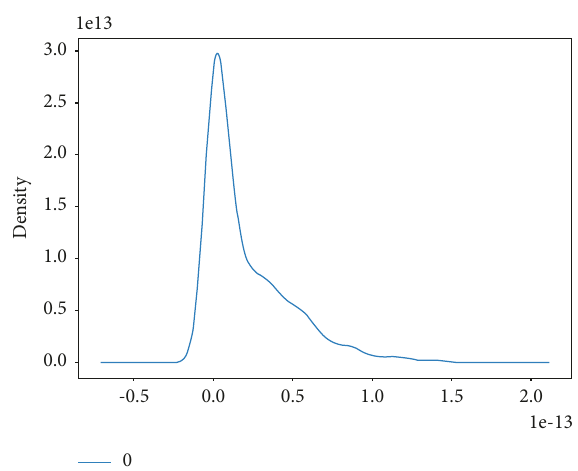
Figure 2: Probability of multivariate Gaussian with Gaussian pyramid 5 × 5.